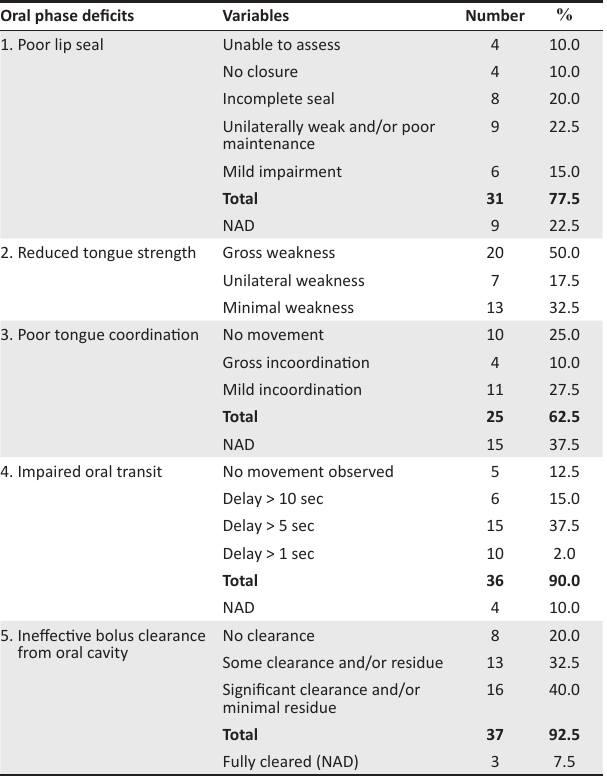
TABLE 2: Predominant deficits affecting efficacy of the swallow ( N =